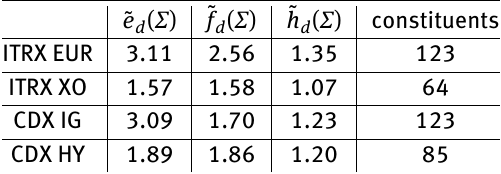
˜ e ( Σ ) ˜ f ( Σ ) ˜ h ( Σ ) d d d